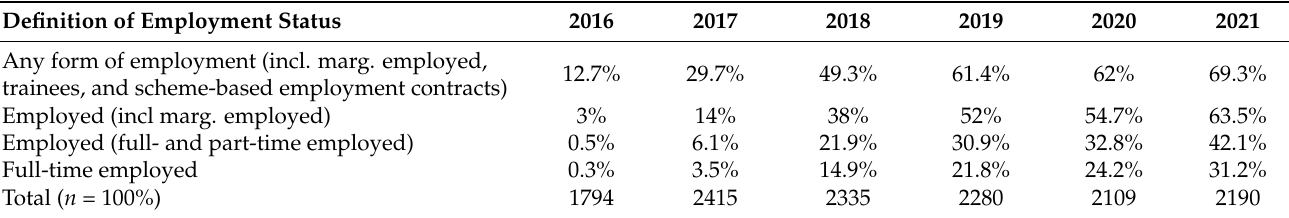
Table 1. Respondents’ employment status